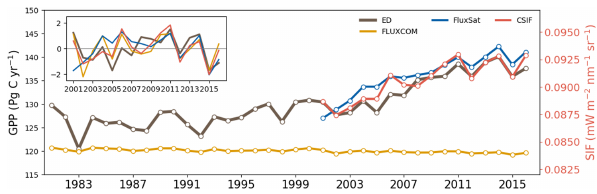
Figure 7. Time series of the global annual total GPP (from ED, FLUXCOM and FluxSat) and the global annual average CSIF. Their interannual anomalies are shown in the